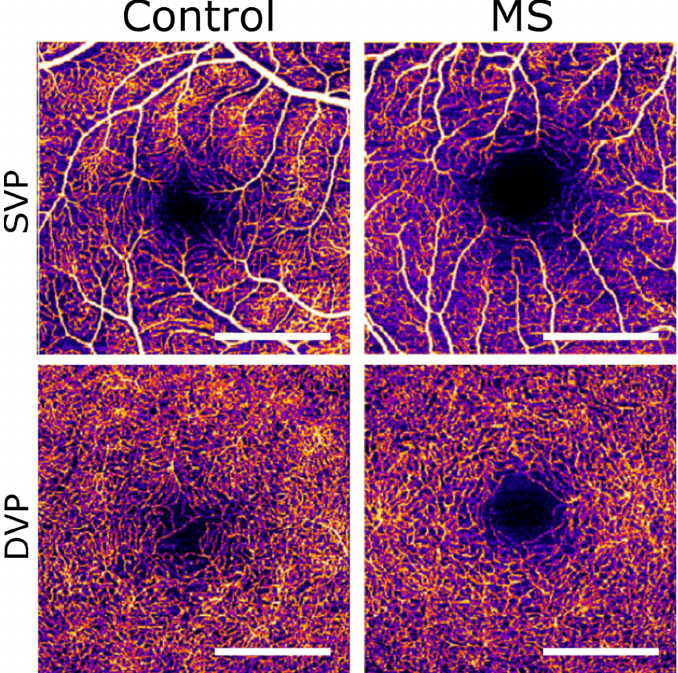
Figure 4. OCT-A scans of superficial (SVP) and deep (DVP) vascular plexus of a healthy control (left column) and of an MS patient (right column). The FAZ is enlarged in the retina of the MS patient. Scale bar: 1mm. Scans are 3 × 3 mm and obtained with the Heidelberg Engineering OCT2 system with 85.000 scanning speed. FAZ = foveal avascular zone, MS = multiple sclerosis. (reprinted with permission from ref. [26]. Copyright 2020 Kleerekooper et al.) .